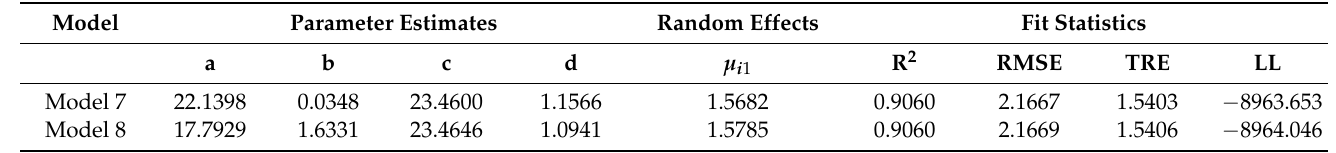
Table 6. Parameter estimates, fit statistics, and standard errors of the model fitted statistics for the Duplat and Tran-Ha I and II parameterized models with random effects included (Equations (7) and (8)).